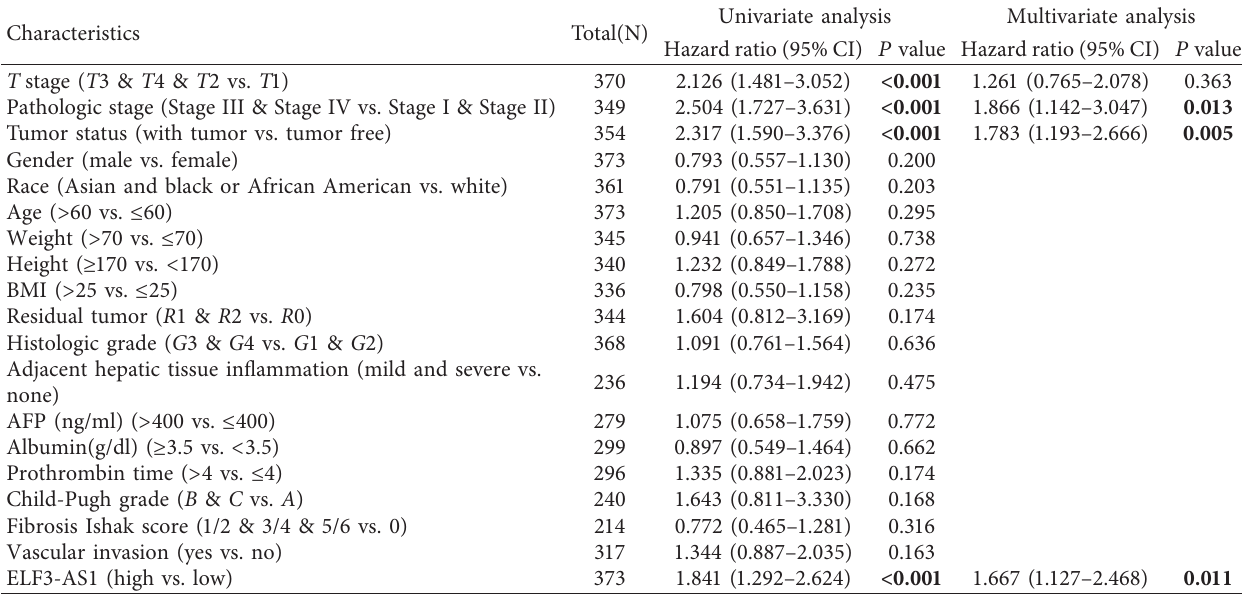
Table 4: Association of OS and clinical characteristics in TCGA HCC patients (Cox regression).